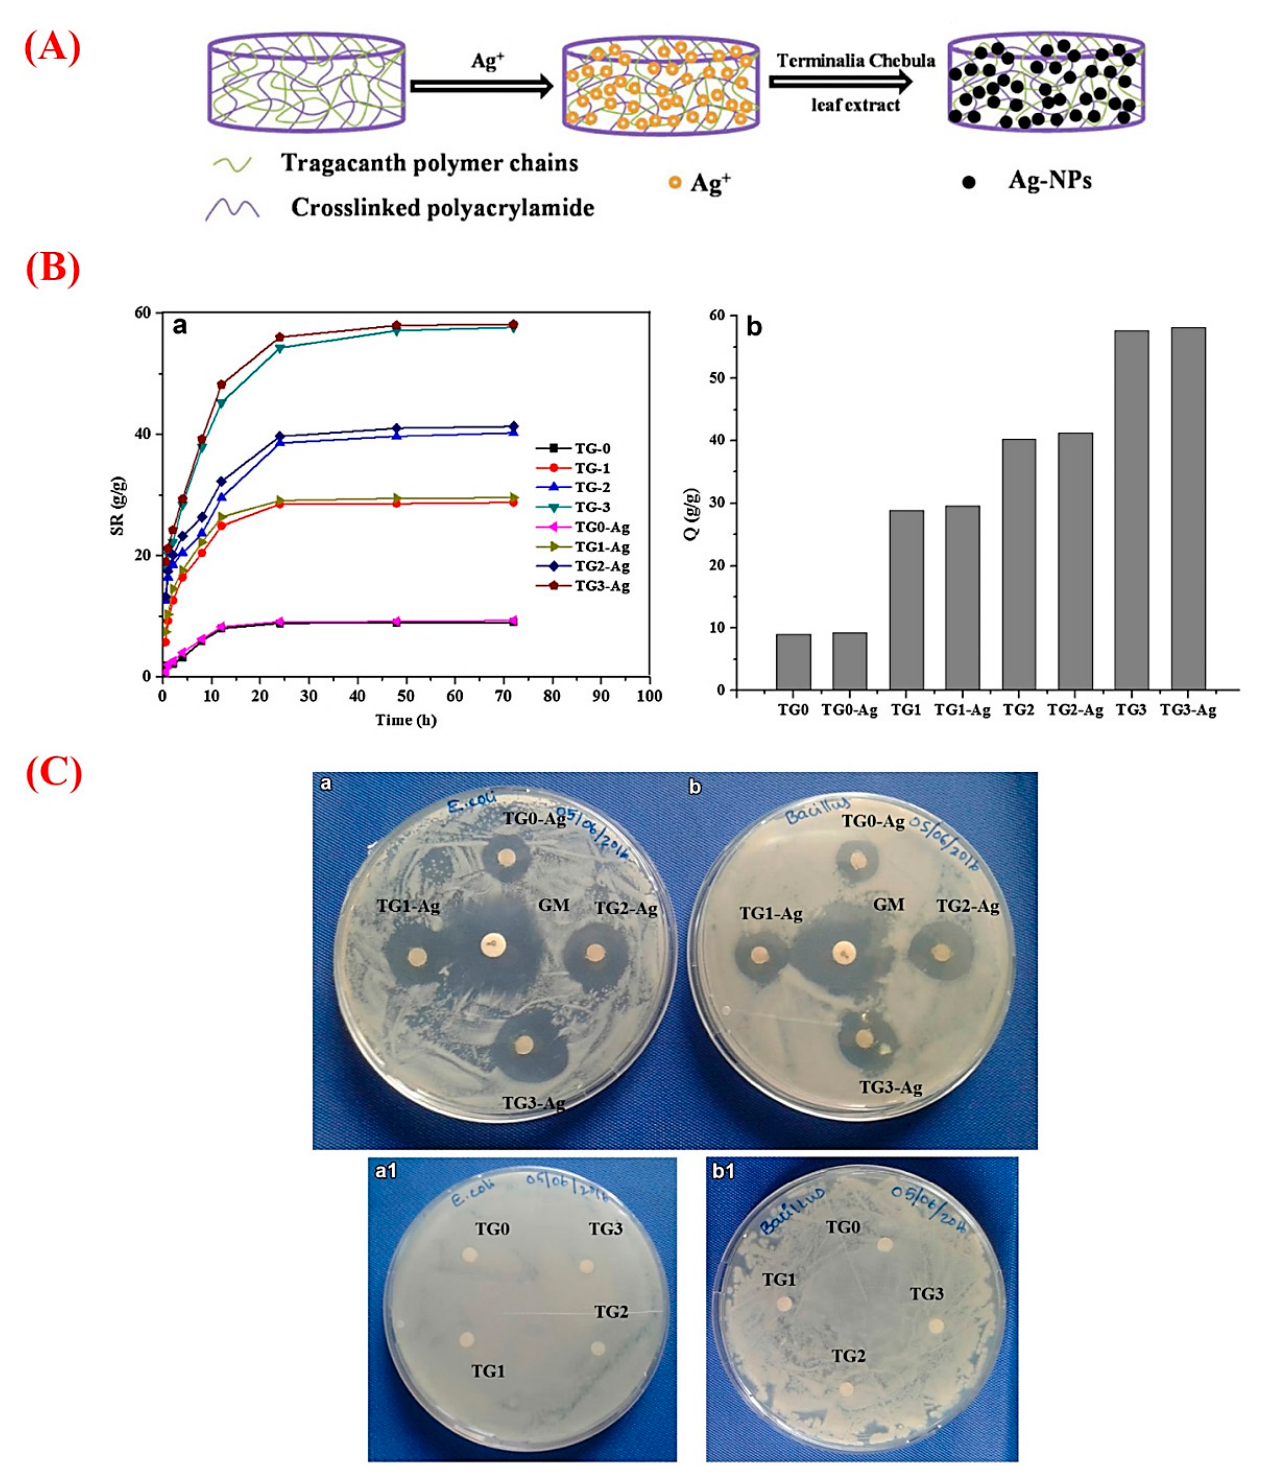
Figure 4. ( A ) Schematic representation of the formation of silver nanoparticles (Ag-NPs) in gum tragacanth (TG) hydrogel networks. ( B ) Graphs a and b exhibiting swelling and equilibrium swelling ratio Q (g/g) of the TG hydrogels (TG0, TG1, TG2, and TG3) and their Ag-NPs embedded counterparts (TG0-Ag, TG1-Ag, TG2-Ag, and TG3-Ag), respectively. ( C ) The results of the antibacterial activity of the Ag-NPs containing TG0, TG1 TG2, and TG3 hydrogels and the pristine TG hydrogels on (a/a1) E. coli , and (b/b1) B. subtilis [Gentamicin (GM) antibiotic is as the positive control]. Note: TG0, TG1, TG2, and TG3 contain 0, 100, 200, and 400 mg of GT. Reproduced with permission from [75], Copyright 2017, Springer